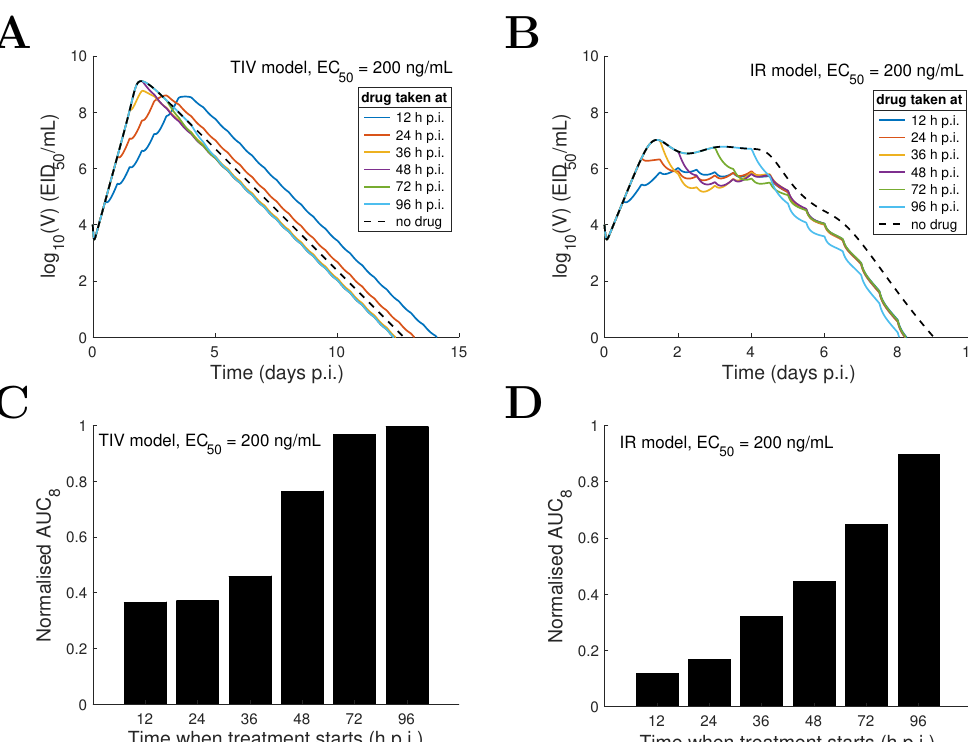
Figure 9. Comparison of model behaviours of the TIV model ( A , C ) and the IR model ( B , D ) for a less effective drug ( EC 50 = 200 ng/mL) and varied drug administration time. The time when drug is first taken is varied from 12 h p.i. to 96 h p.i. and the corresponding viral load solutions are shown in different colours. AUC 8 is normalised to its corresponding quantity in the no-drug control. The solutions with no treatment are shown by dashed black